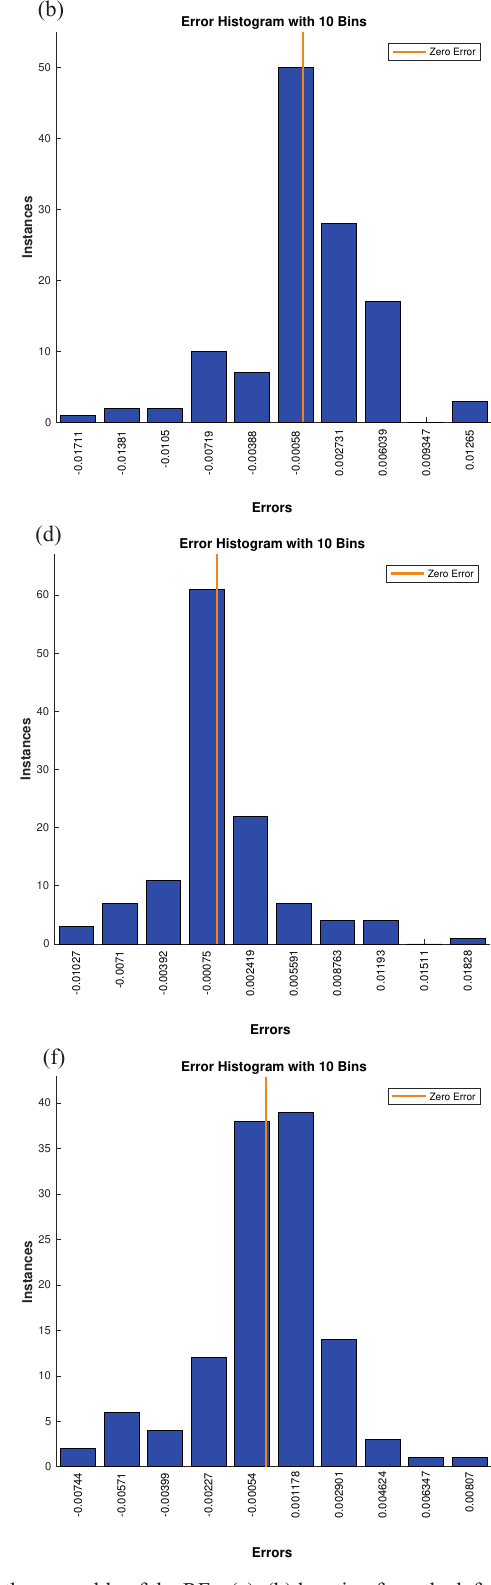
Fig. 4. Correlation and error distribution of the predicted cracks by the ensemble of the RFs: (a)–(b) location from the left side of the beam; (c)–(d) distance between two cracks; (e)–(f) depth of the first crack; (g)–(h) depth of the second crack. ( Continued on the next page.